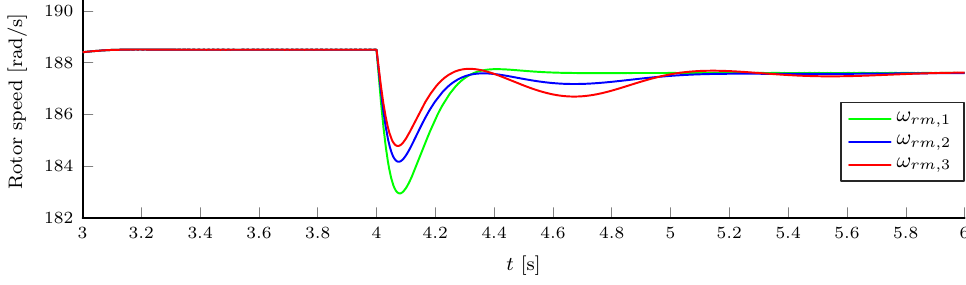
Figure 13. Mechanical rotor velocities (zoomed in); voltage-source control. Figure 12 shows mechanical rotor speed for all motors including the initial start-up period; Figure 13 provides a zoomed-in view of the response after the unequal torque loads are applied. As shown in Figure 13, the transient rotor response resolves in approximately 2 s. All IM rotor speeds reach approximately 187.6 rad/s after reaching steady-state; the small steady-state speed error (0.5%) is a result of the open-loop speed control used in this study (see Figure 5).